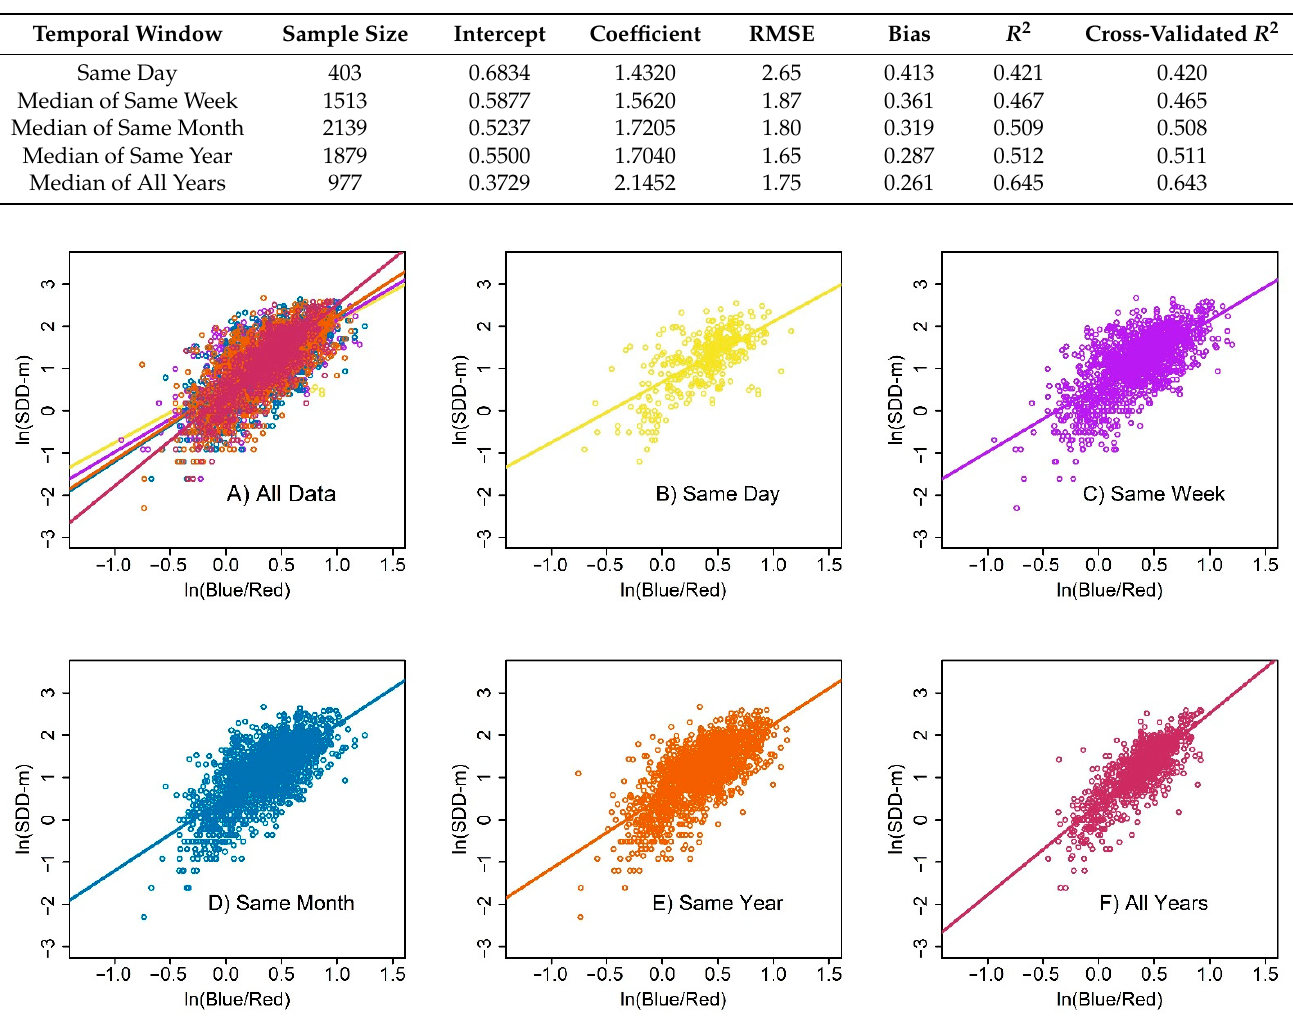
Table 4. Regression models estimating in situ SDD from Landsat 8 Blue/Red surface reflectance for different temporal windows. (RMSE = root mean square error).